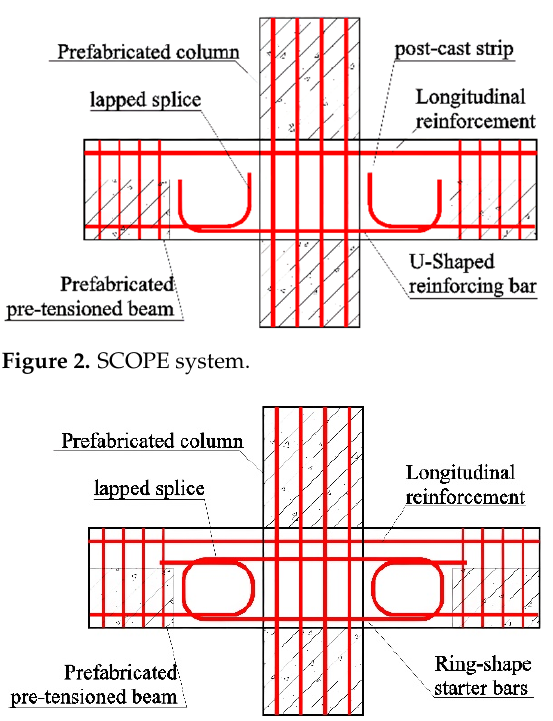
Figure 1. Traditional prefabricated beam-column joint.